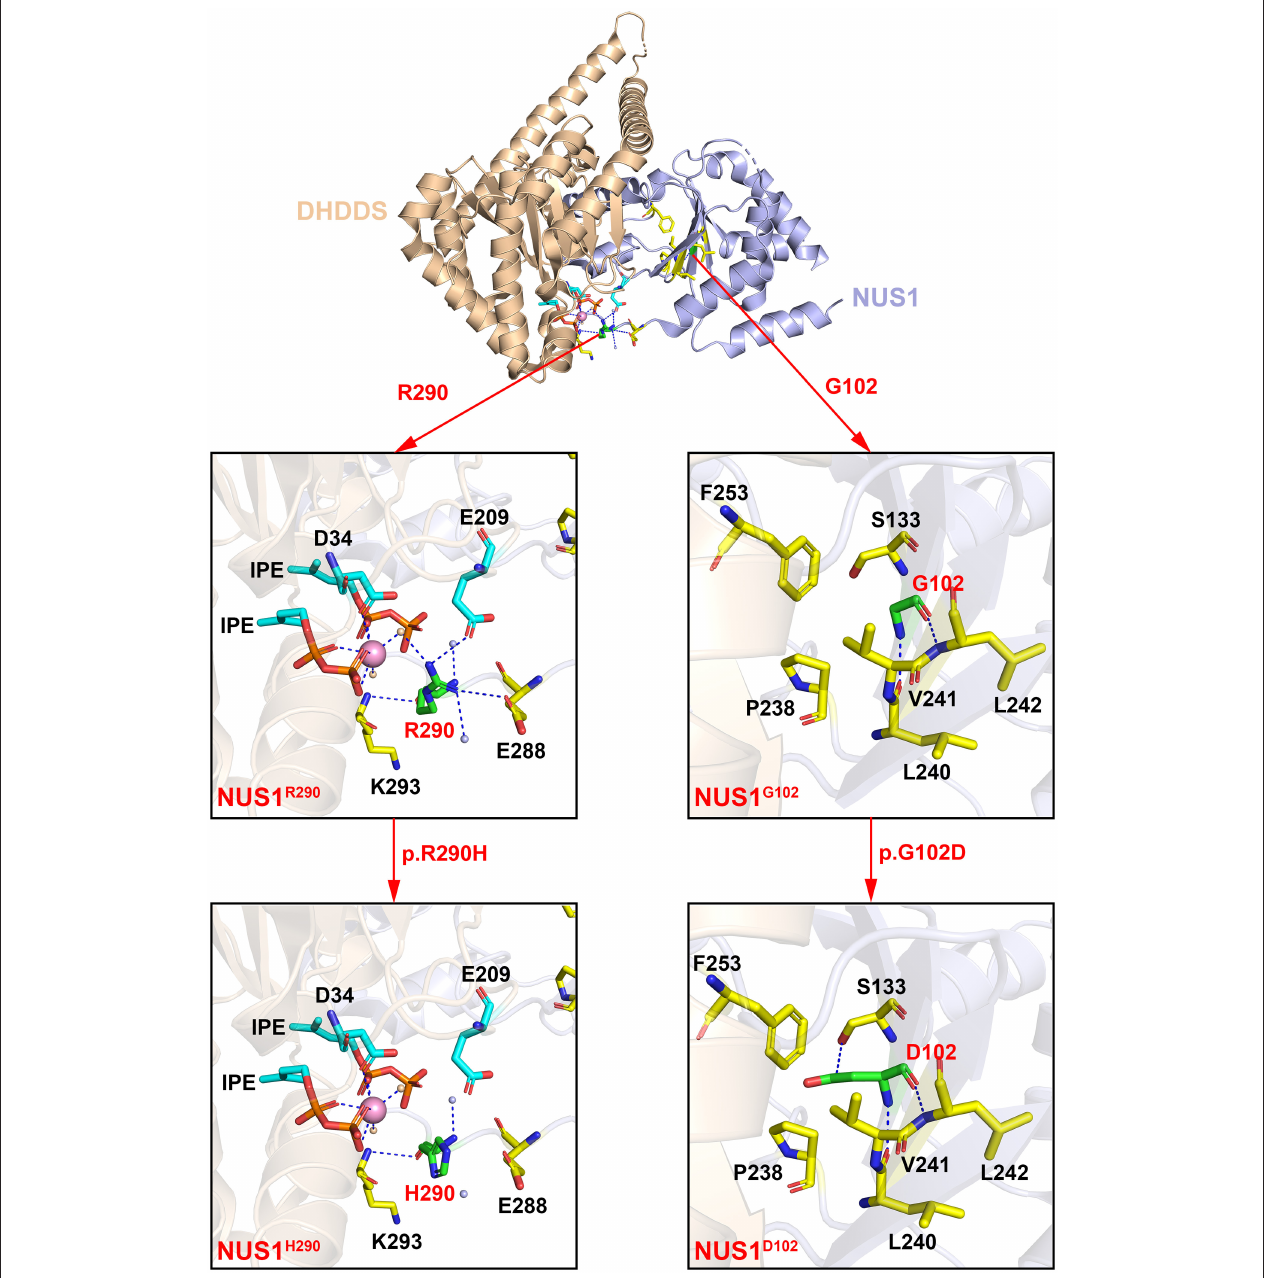
FIGURE 2 | The crystal structure of the human NgBR/DHDDS complex (PDB code: 6W2L). Shown are the cartoon representation of the wildtype NgBR/DHDDS structure and the G102, R290 mutants. The DHDDS and NgBR subunits of the heterodimer are colored in wheat and light blue, respectively. Residues G102, R290 and their pathogenic variants D102, H290 are shown in green sticks. D34, S133, E209, P238, L240, V241, L242, F253, E288, E293 and two IPEs are shown in sticks and highlighted in cyan (DHDDS subunit) and yellow (NgBR subunit). The water molecules of DHDDS and NgBR are colored in orange and light blue, respectively. The metal ion Mg 2 + is colored in pink. All the structural figures were generated using PyMOL (http://www.pymol.org).